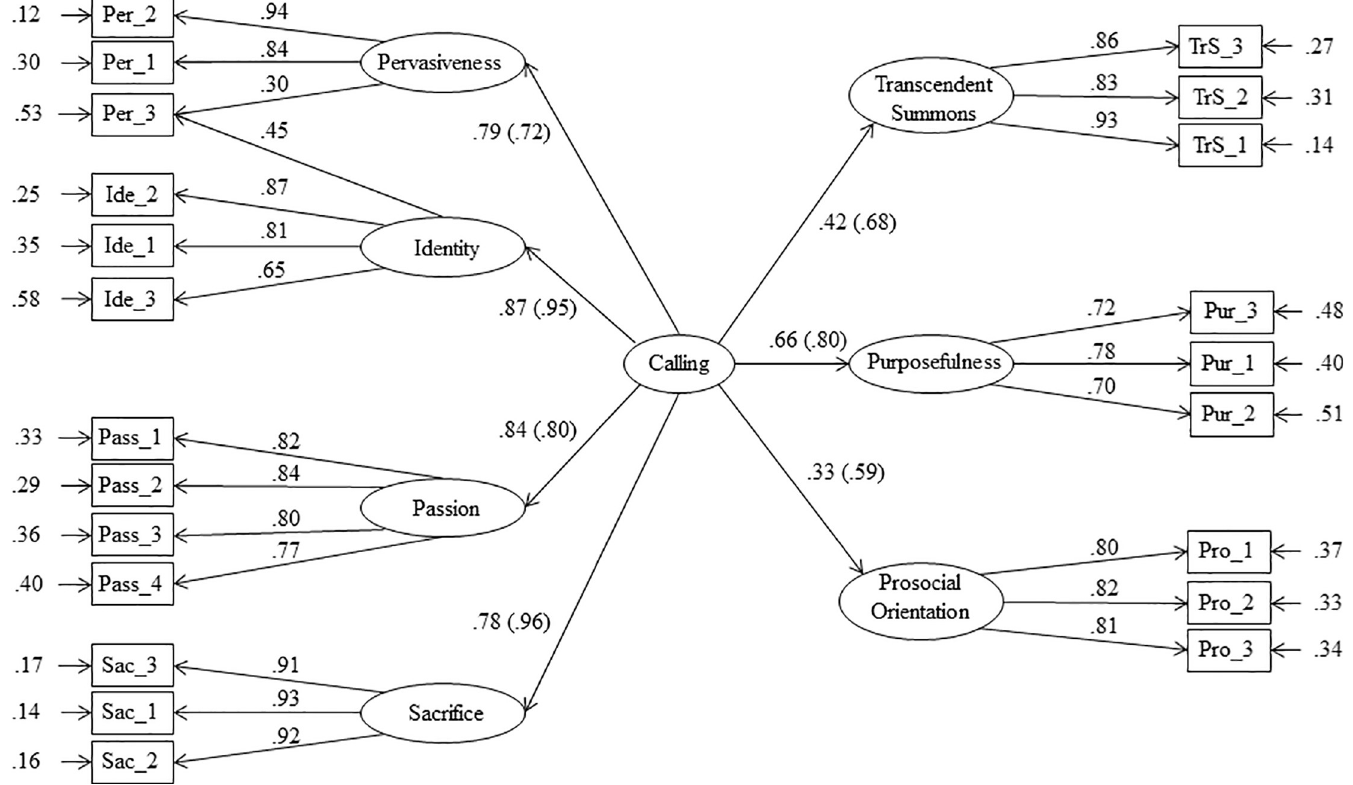
Fig 1. Model 2: The best fitting second order factor model for students. ( χ 2 (201) = 1274.24, CFI = .955, RMSEA = .056, 95% CI [.053 - .059], SRMR = .039). Loadings in parentheses are estimated on a sample of working adults.